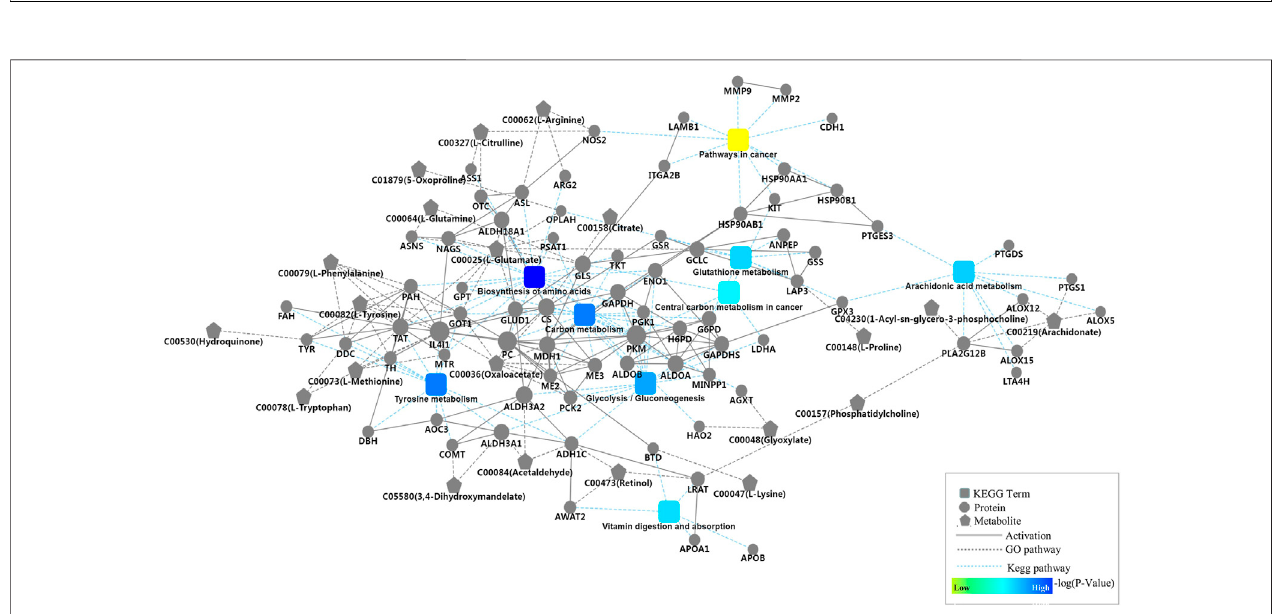
FIGURE 3 | Protein-protein interaction network analysis based on nine key pathways associated with cancer cell metabolism, which involved glycolysis/ gluconeogenesis, carbon metabolism, protein digestion and absorption, biosynthesis of amino acids, glutathione metabolism, vitamin digestion and absorption, central carbon metabolism in cancer, arachidonic acid metabolism, and tyrosine metabolism, as well as 80 proteins and 21 metabolites.